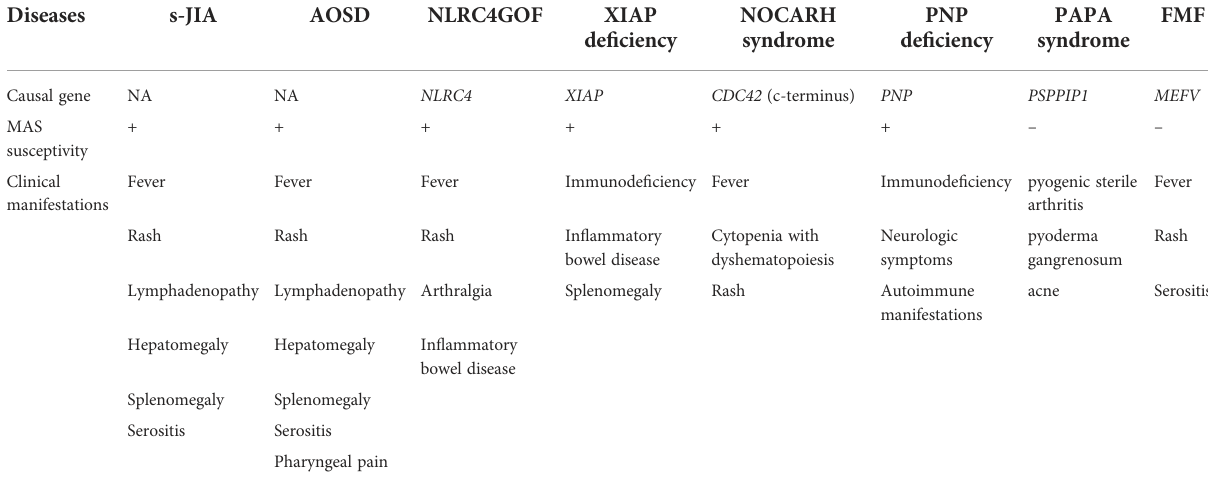
TABLE 1 Autoin fl ammatory diseases characterized by high levels of IL-18.